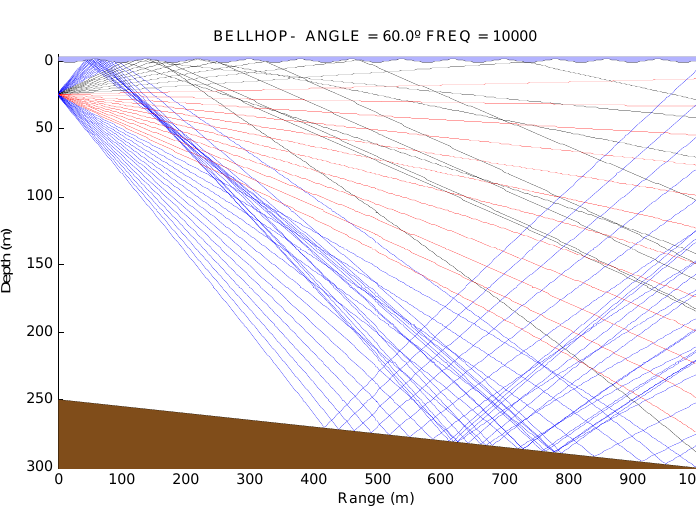
Figure 1. Bellhop ray